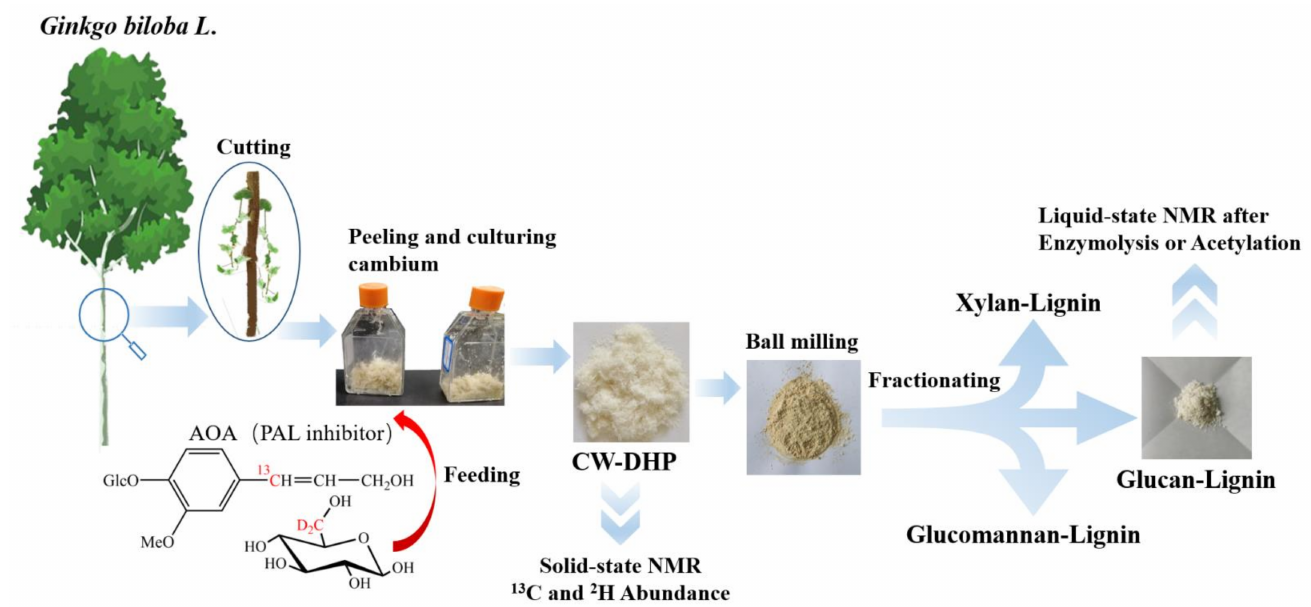
Figure 1. Schematic illustration of the preparation and analysis of specifically 13 C- 2 H-enriched LCC fractions in ginkgo CW-DHP.